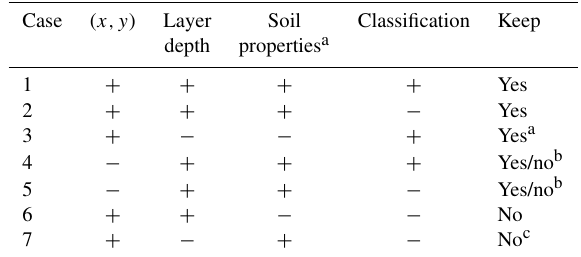
metadata (currently representing some 452 000 profiles) and Table 1. Basic requirements for considering soil profiles in the WoSIS standardisation